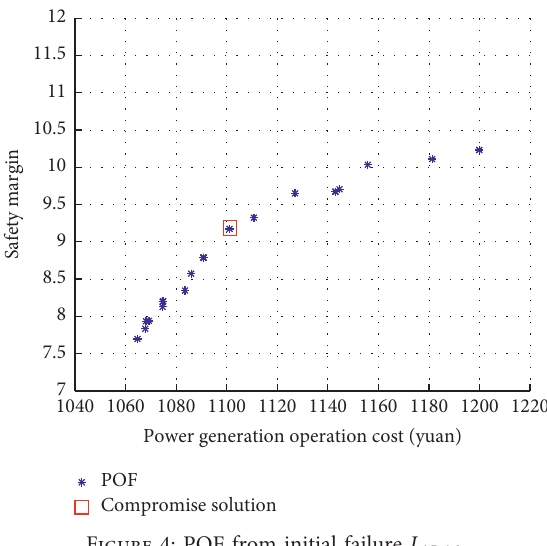
15-16 and L 21-22 at the same